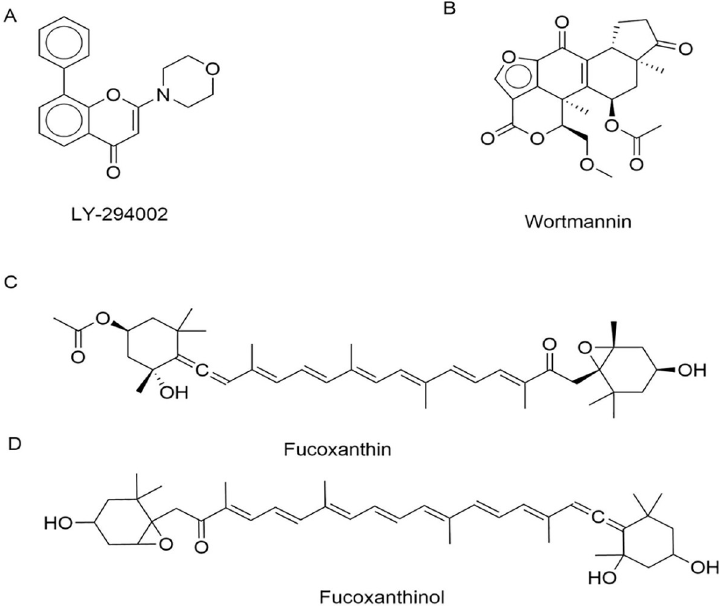
Fig 1. Chemical structures of the PI3K inhibitors discussed in this study. A, LY-294002; B, Wortmannin; C, the natural product fucoxanthin; D, Fucoxanthinol, the deacetylated metabolite of fucoxanthin.